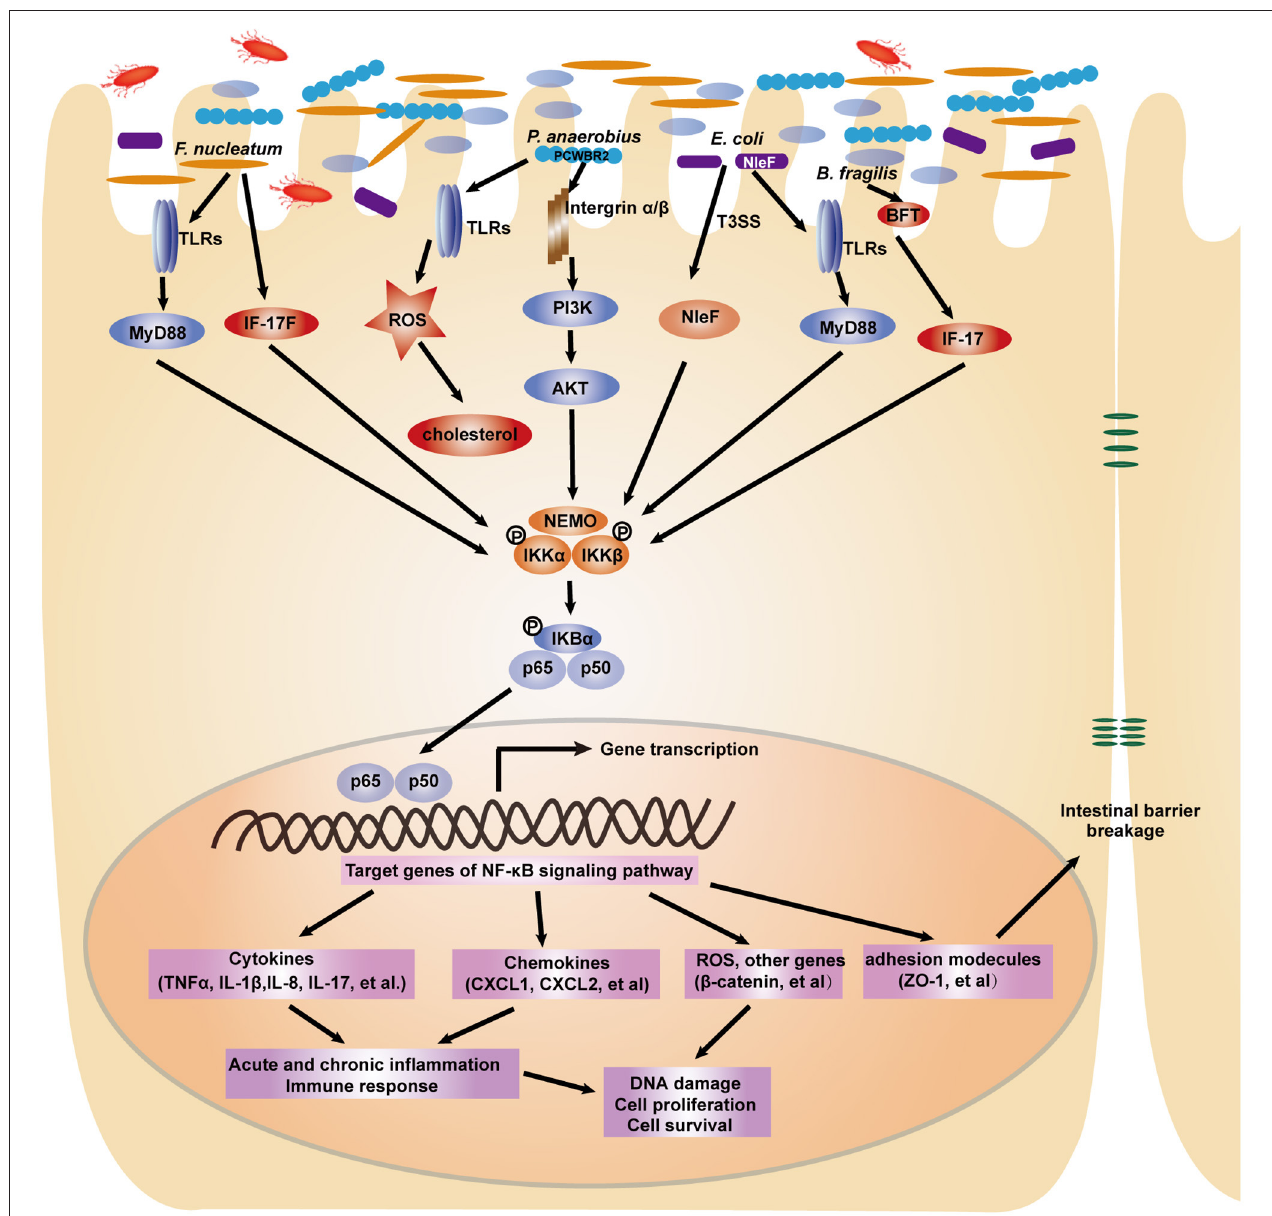
FIGURE 3 | A depiction of the modulation of NF- κ B signaling pathway by gut microbiota in colorectal tumorigenesis. In response to intestinal bacterial pathogens including F. nucleatum , P. anaerobius , E. coli , B. fragilis , intestinal epithelial cells employ several receptors such as TLRs and integrins to recognize distinct microbial components. The NF- κ B signaling pathway is subsequently activated to induce the expression of pro-inflammatory cytokines, chemokines, adhesion molecules and other genes, which ultimately lead to the cellular processes changes and contribute to colorectal carcinogenesis.